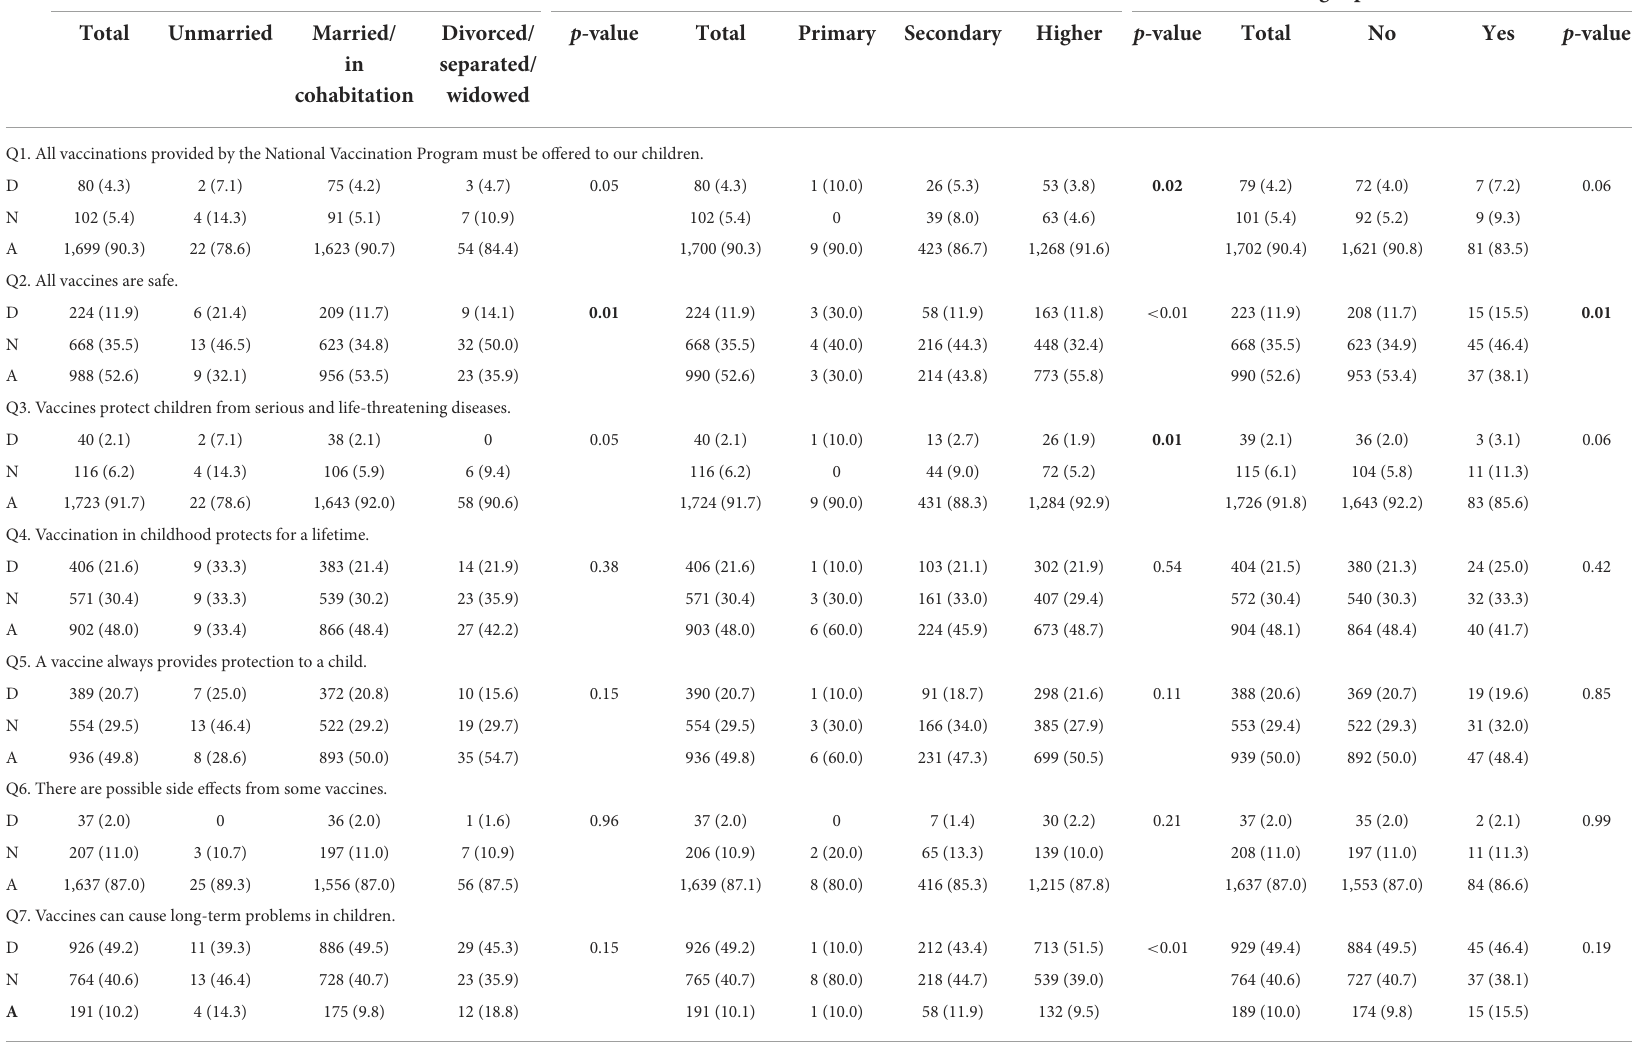
TABLE 2 Maternal responses to questions about vaccination attitudes by marital status, educational attainment, and single parent